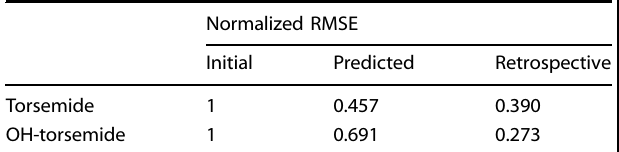
Table 2. Quantitative assessment of PK prediction